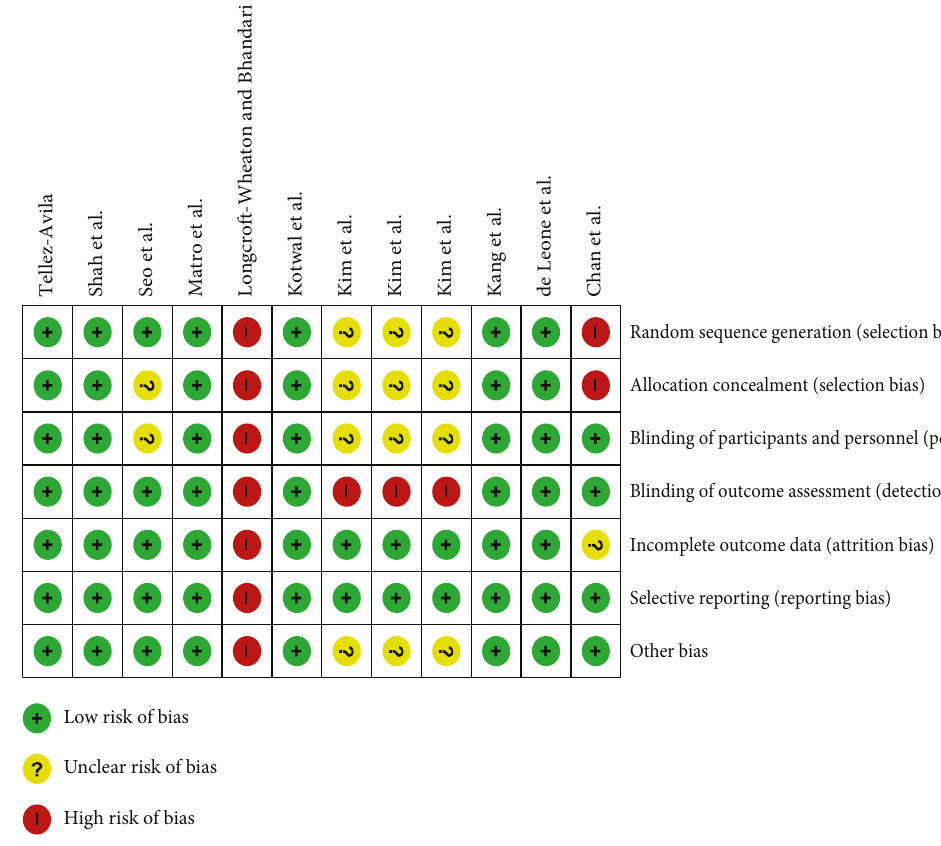
Figure 2: Risk of bias summary: a review of the authors ’ judgments about each risk of bias item for each included